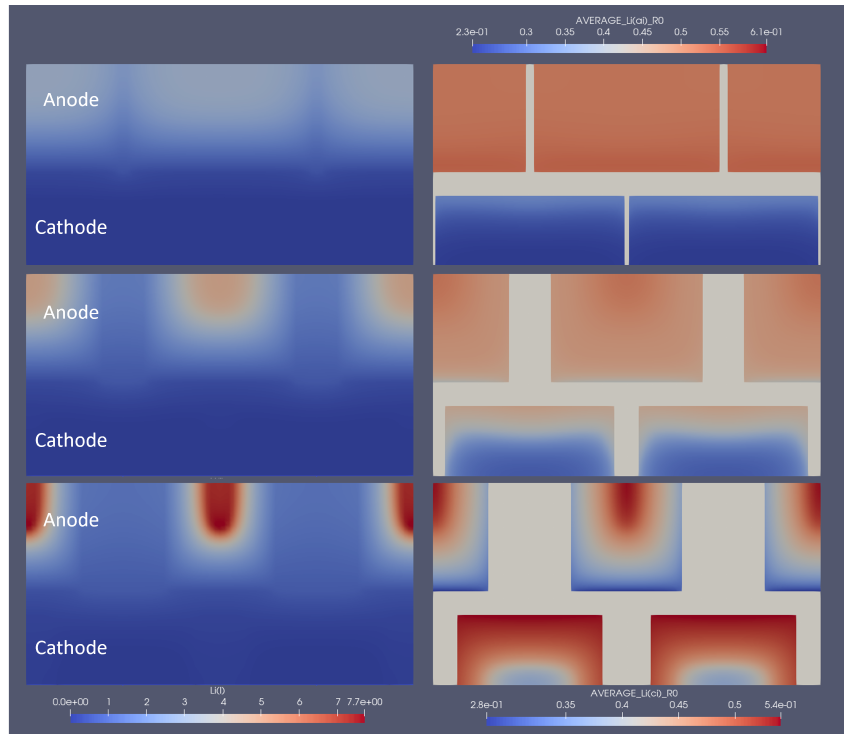
Figure 6. Snapshot of the lithium concentrations in electrolytes and solids for line structuring at the end of the 3C discharge cycle. The left part shows the concentration in the electrolyte, and the right part shows the average particle concentration in the respective electrodes. The bottom shows the optimal parameters, whereas the middle row shows 50% of that structuring amount, and the top part shows 10% for comparison. 2.3e-01 represents 2.3 × 10 − 1 , the same rule applies to other E